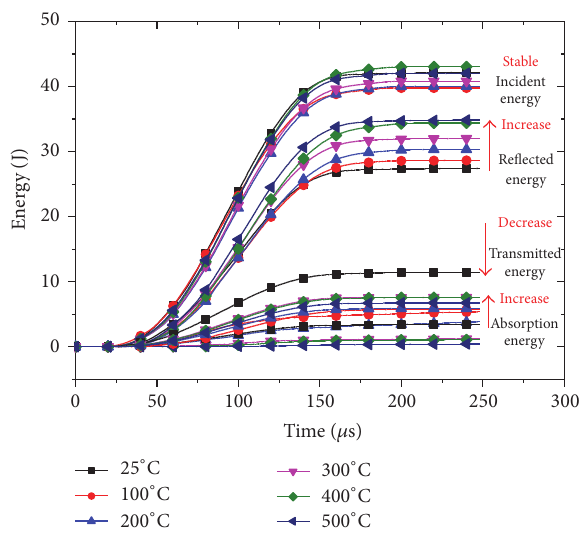
Figure 5: Time history curves of energy under impact loading.